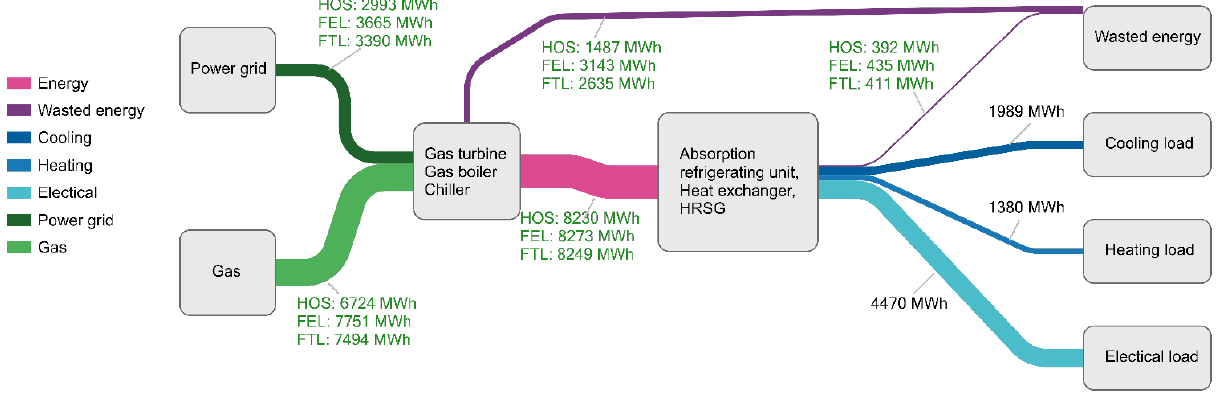
Figure 9. The energy flow of the DES with HOS, FEL and ETL. The 100 sets of discrete loads with a θ from − 0.06 to 0.11 and their typical daily loads were input into the algorithm for the optimization of the DES-HOS. The scatters and fitting lines of the ATC, CE, EE, and CEI are shown in Figure 10. The annual total cost of the DES optimized based on annual hourly load was 4.7% to 6.2% less than that of a typical daily load (Figure 10a). The annual operational cost of the DES-HOS increased by 3.4% and 6.5% as the θ increased from − 0.05 to 0.1, respectively. The increase in grid power consumption was the main reason for the increase in the annual operational cost of the DES-HOS. Figure 10b shows that the carbon emissions of the DES optimized base on annual hourly load were 8.7% to 12.5% less than the typical daily load. The energy efficiency of the DES optimized base on annual hourly load was 2.5% to 4.7% higher than the typical daily load (Figure 10c). As θ increased from − 0.05 to 0.1, the energy efficiency of the DES decreased by 2.1% and 5.3%, respectively. Figure 10d shows that the CEI of the DES-HOS based on annual hourly load was 4.7% to 6.2% less than the typical daily load. As the θ increased from − 0.05 to 0.1, the CEI of the DES-HOS decreased by 1.8% to 2.6%, respectively.